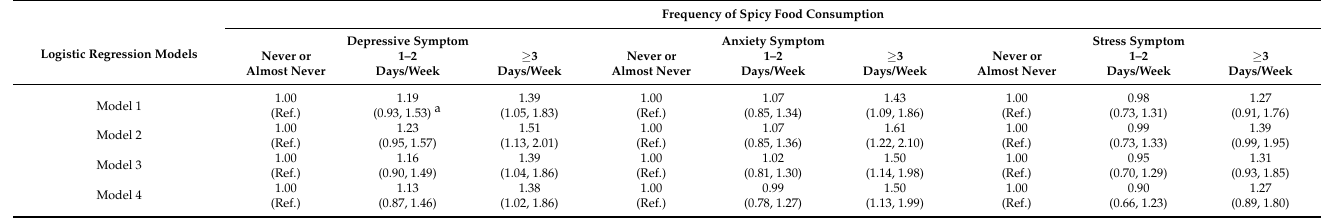
Table 2. Regression coefficients (95% CI) for psychological health by frequency of spicy food con- sumption among Chinese college